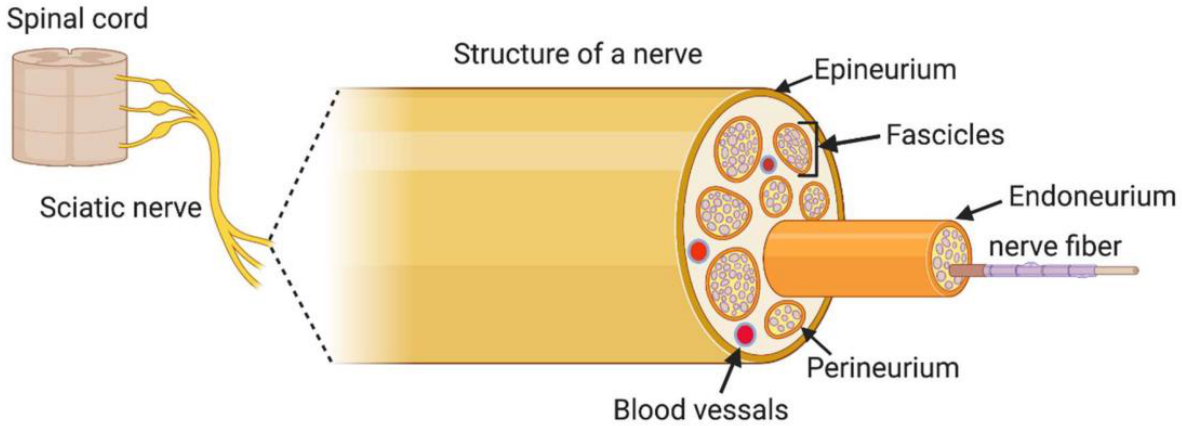
Figure 1. Structure of a peripheral nerve. Reproduced with permission from [1], Copyright © 2020 Published by MDPI.